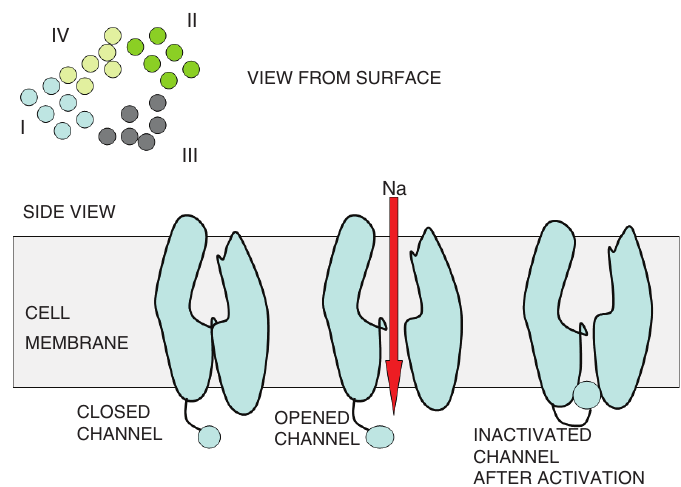
Figure 2. An idealized drawing of α and β units of VGSCs.